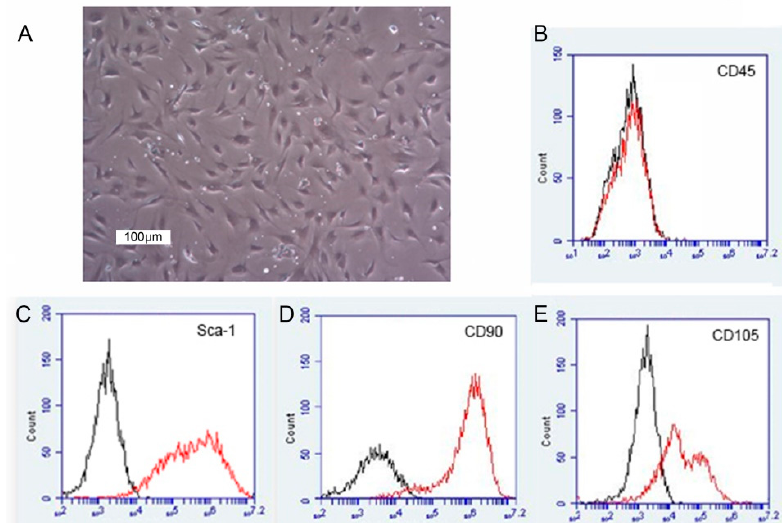
Figure 1. Characterization of luciferase-transgene mesenchymal stem cells from murine inguinal adipose tissue in passage 3 (Luc + -mASCs). ( A ) Phase contrast microscopy and surface expression of characteristic antigens of Luc + -mASCs in primary cell culture. ( B – E ) Representative flow cytometric histograms of the markers CD45-FITC ( B ), Sca-1-APC ( C ), CD90-PE ( D ), and CD105-APC ( E ). Unstained cells served as negative control (black lines). Int. J. Mol. Sci. 2018 , 19 , x FOR PEER REVIEW